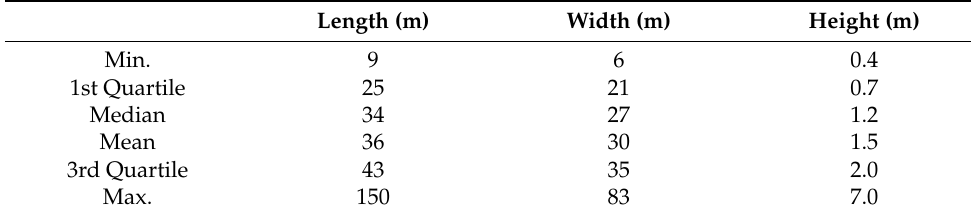
Table 1. Basic statistics of the metric attributes of the mounds. Length (m)